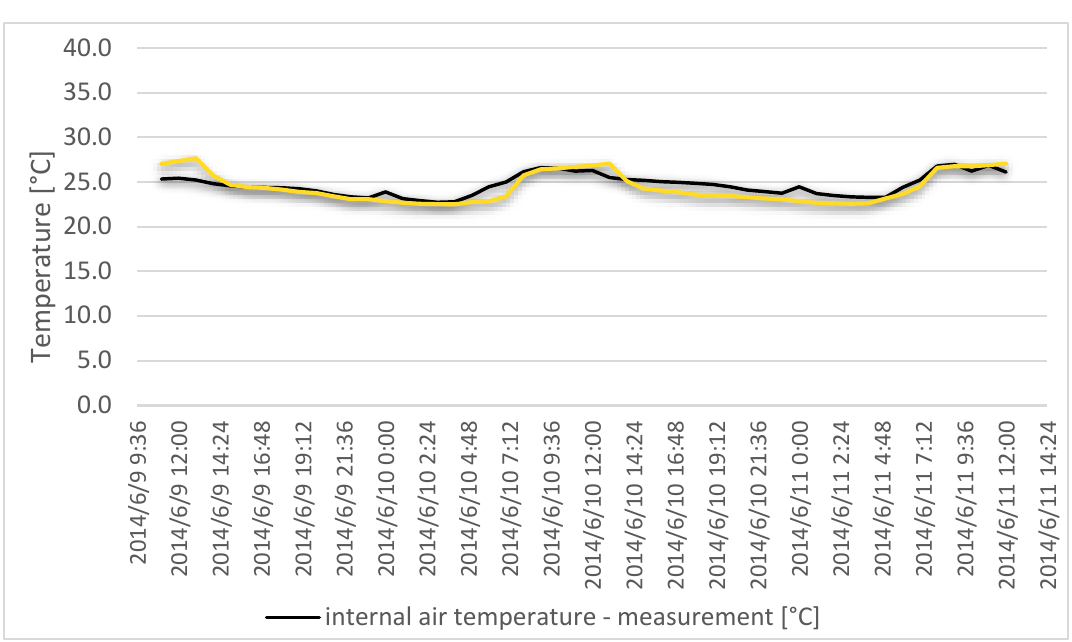
Figure 8. Indoor air temperature distribution during the summer measurement in 2014 and the values obtained from the simulation model for the classroom studied.